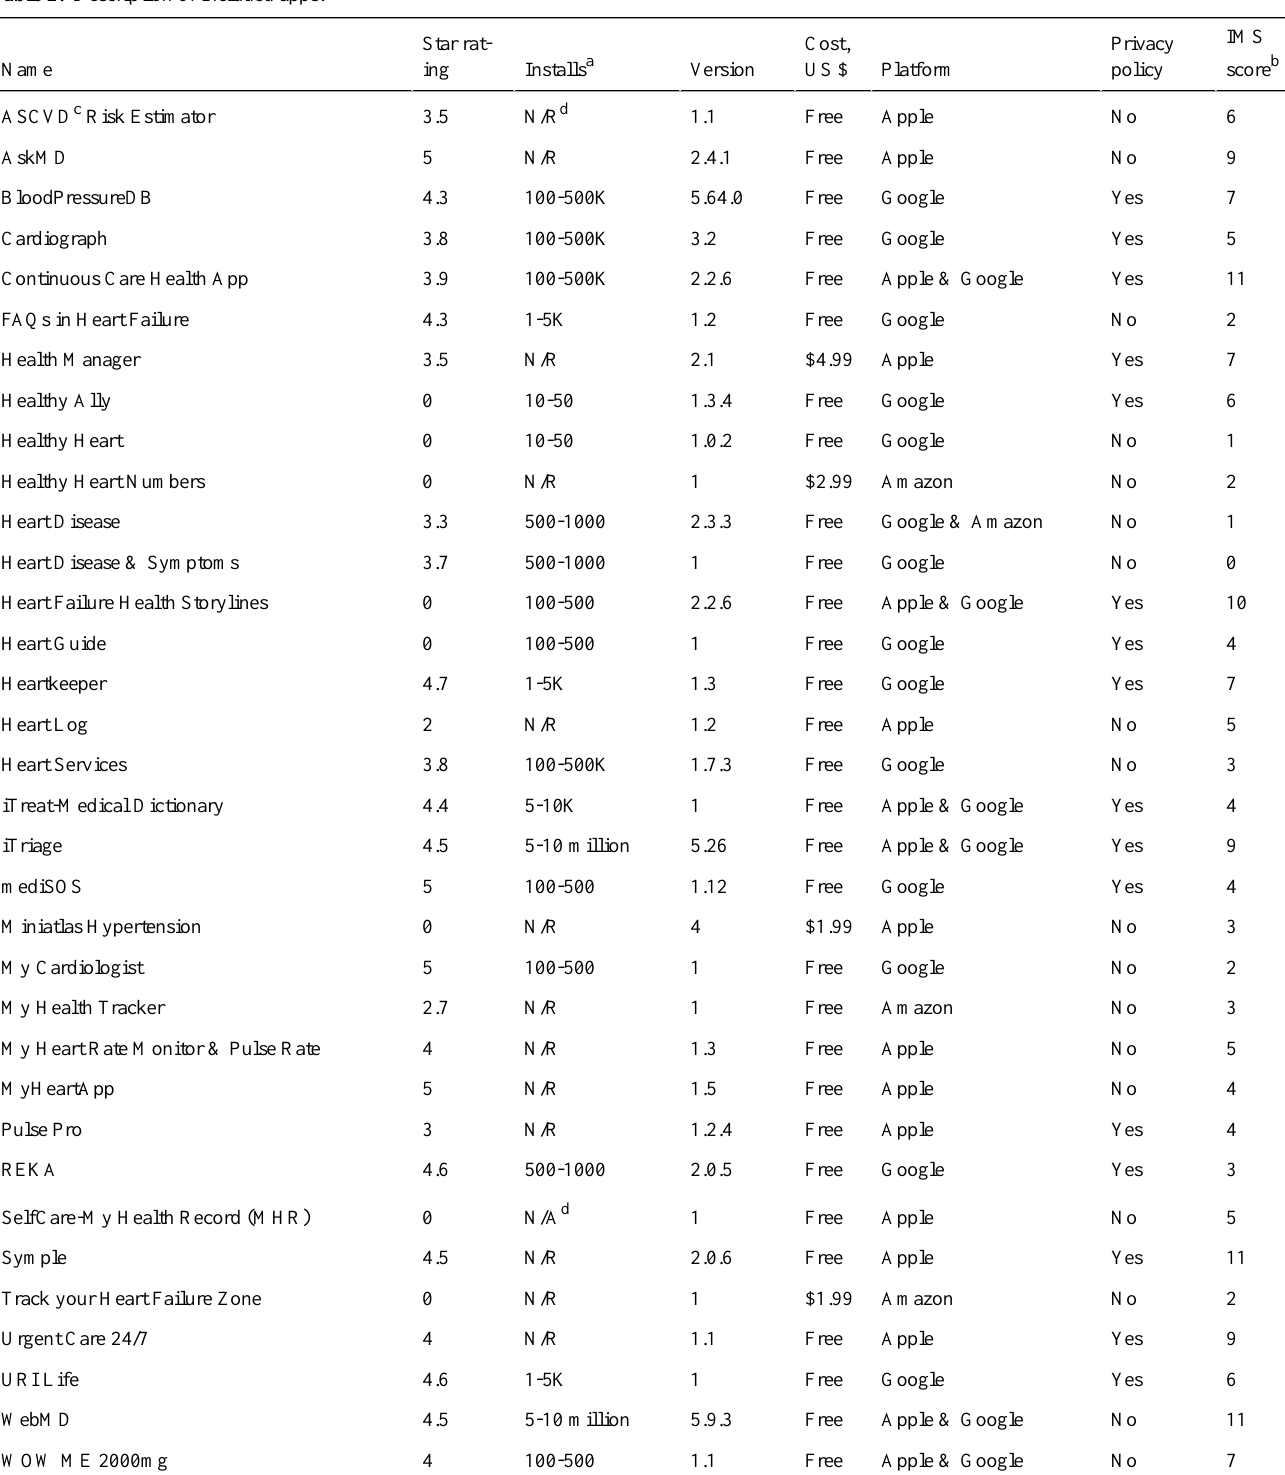
Table 2. Description of included apps.